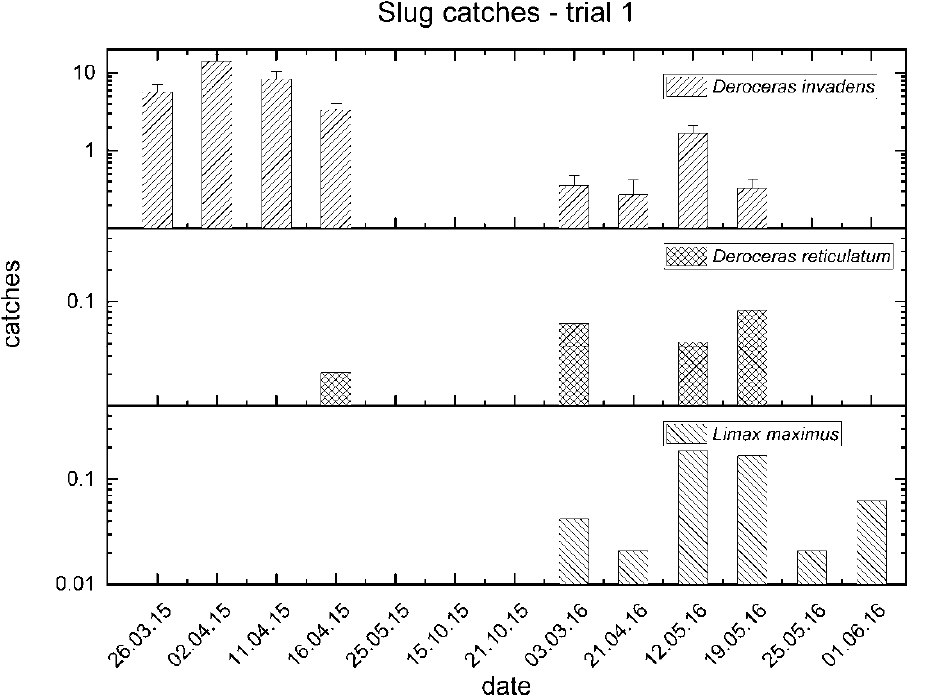
Figure 1. Mean catches of slugs between March 2015 and June 2016 in trial no. 1.